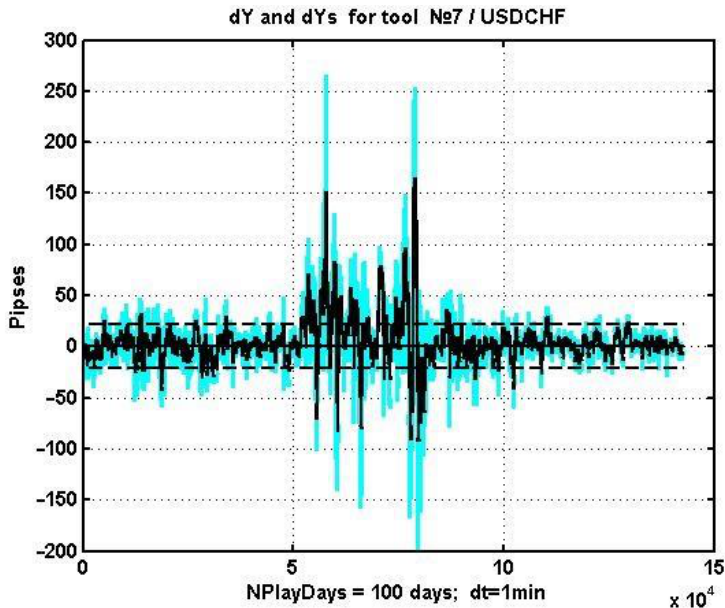
Figure 5. Process d k , its smoothed version, and the levels of SD.